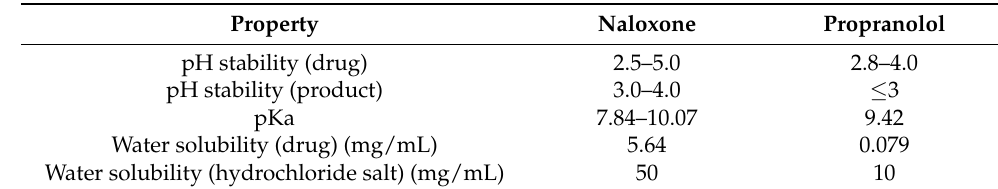
Table 1. Physicochemical properties of the active pharmaceutical ingredients used in the liquid formulations